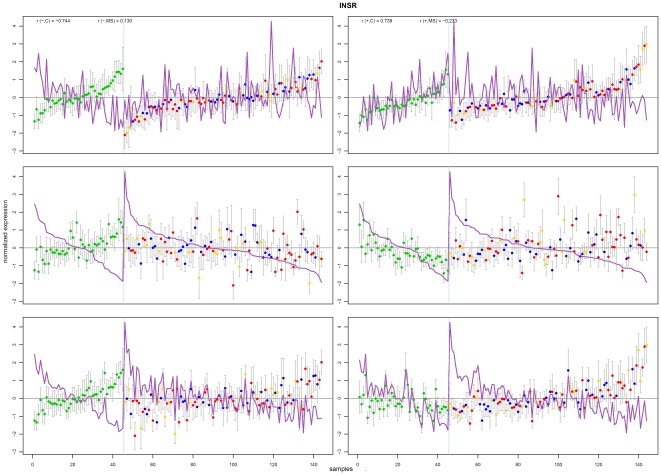
Correlation plot for the insulin receptor star centre (INSR).The figure shows the correlation of scaled expression values of INSR (insulin receptor, purple line) with the average of negatively (left column) and positively (right column) correlated neighbour probes (coloured dots). The light blue vertical line separates control samples to the left and MS to the right. The figures show three different orderings: by the harmonic mean of neighbours (top row), by the star centre expression value (middle row) and by the difference between star centre and neighbours average (bottom row). The class correlation values of star centre with neighbours are shown in the top figure; for example, r(−,C) is correlation coefficient of negatively correlated probes with control samples and r(+,MS) is the correlation of positively correlated probes with MS samples. Dot colours indicate sample class: green – control, blue – PPMS, red – RRMS, yellow – SPMS. This graph illustrate patterns of differential co-expression in Control versus MS samples. In particular, on the left it can be observed that some neighbours are strongly anti-correlated with the star centre in controls (correlation coefficient −0.744) but weakly correlated in MS (0.130); on the right, the remaining neighbours are strongly correlated with the centre in controls (0.739) but weakly anti-correlated in MS (−0.233).